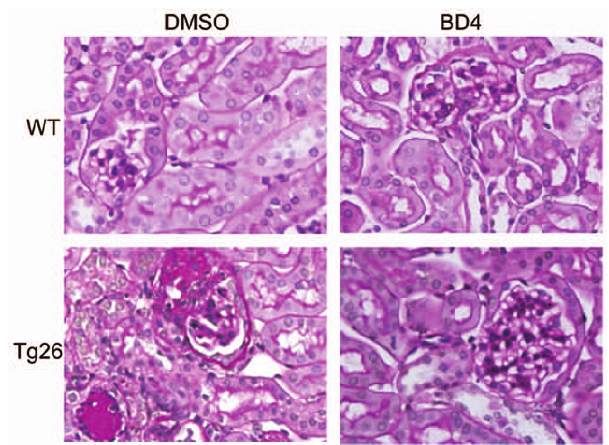
Figure 6. Kidney histology. Both Tg26 and WT mice were fed with either control vehicle or BD4 by daily gavage from 4 to 12 weeks of age. Mice were sacrificed at 12 weeks of age and the kidneys were removed for histology analysis. The representative H&E stained sections from six mice in each group are shown.